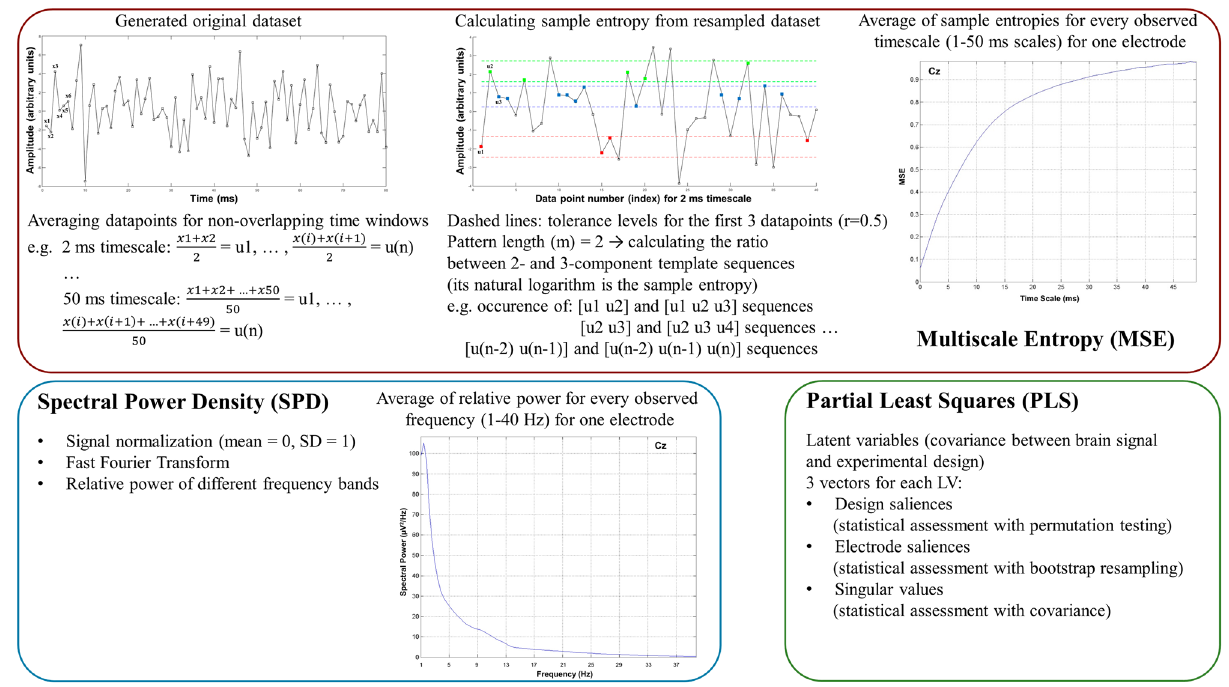
Figure 2. Illustration and summary of the applied analysis